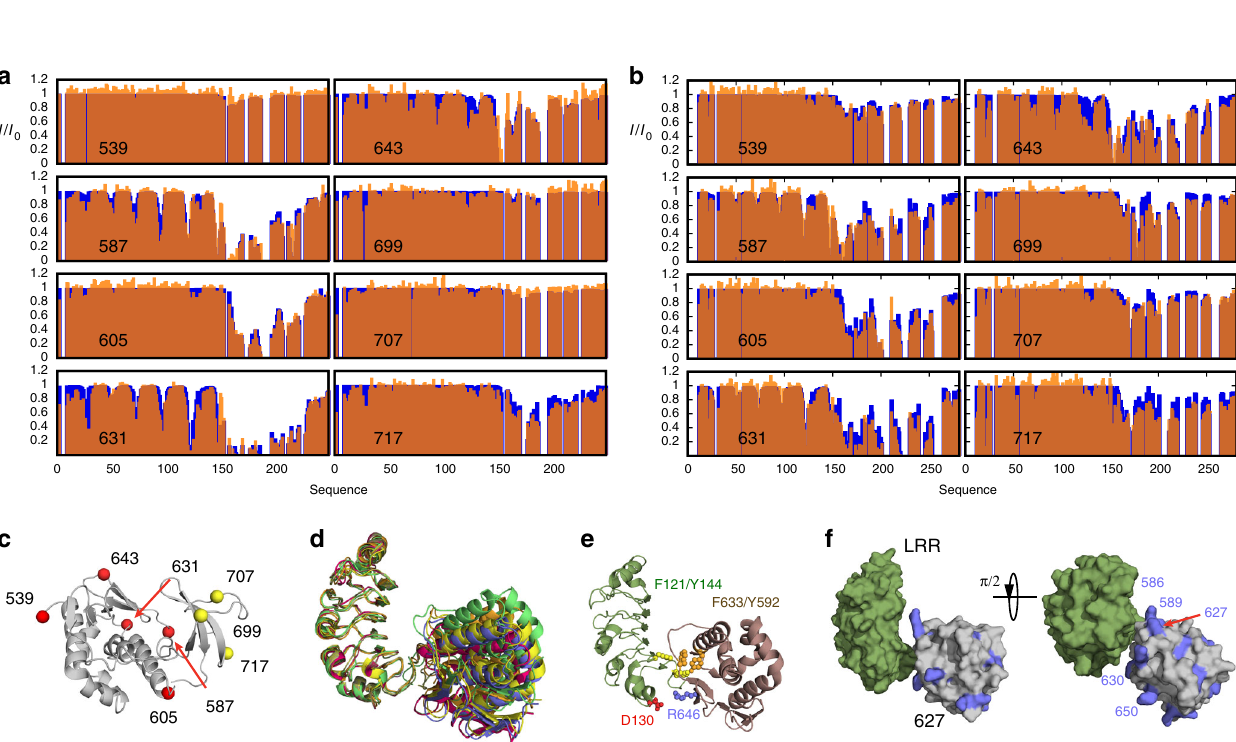
Fig. 2 Interaction of 627-NLS and ANP32A observed from the perspective of 627-NLS. a Representation of the domains of 627-NLS. The C-terminal domains of PB2 comprise two sub-domains (627 — orange and NLS — grey) connected by a linker (red) and terminated by an NLS peptide (NLS). The molecule exists in equilibrium between closed and open forms that exchange at 50 s − 1 at room temperature. The position of the E627K adative mutation is shown in blue. b HSQC of the open-only form of 2 D, 13 C and 15 N-labelled 627-NLS(K) (D730A/E687A; 200 μ M; red), indicating chemical shifts of selected sites upon addition of h ANP32A IDD (400 μ M blue). c CSP of 627-NLS(K) (300 μ M) upon addition of h ANP32A IDD at a ratio of 1:4 (red) and 627-NLS(E) (300 μ M) upon addition of av ANP32A IDD at a ratio of 1:4 (blue). Spectra recorded on 2 D, 13 C and 15 N-labelled 627-NLS at 293 K and 850 MHz. Only shifts affecting resonances corresponding to the open form are shown for clarity. d CSP of 627-NLS(K) (red) induced by addition of h ANP32A derived from b above the threshold of 0.25 (dashed line) for 627 (grey) and NLS (yellow) domains. Two orientations of the protein are shown. e Distribution of basic sidechains (blue) on the surface of the 627 and NLS domains. By comparison with c , it is evident that one of the two faces preferentially interacts with the IDD. f Represention of the largest differential shifts on the surface of the 627 domain upon addition of ANP32A as shown in c . Amino acids showing the largest difference in CSP (>0.15) in the 627-NLS(K): h ANP32A IDD complex compared to the 627-NLS(E): av ANP32A IDD are highlighted in red (position of 627 shown in blue). g Interaction of full-length 627-NLS with ANP32A induces a change in the open-closed equilibrium. Red — peaks reporting on the open and closed forms of 627-NLS(E) or 627-NLS(K) before the addition (blue) of h or av ANP32A, respectively. The interaction with ANP32A potentiates the equilibrium in both cases, fully removing the closed form in the case of the avian pair. Residues distal from the main interaction site were chosen to reduce the risk of peak disappearance due to direct interaction.